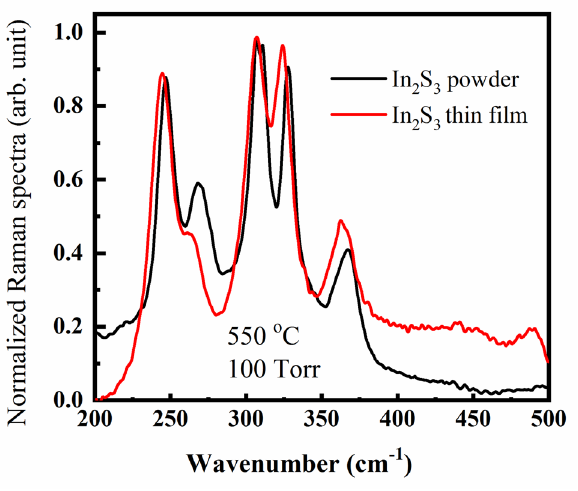
Figure 9. Raman spectra of In 2 S 3 thin film at a temperature of 550 °C and pressure of 100 Torr. (red color) and powder (black color) as a reference.